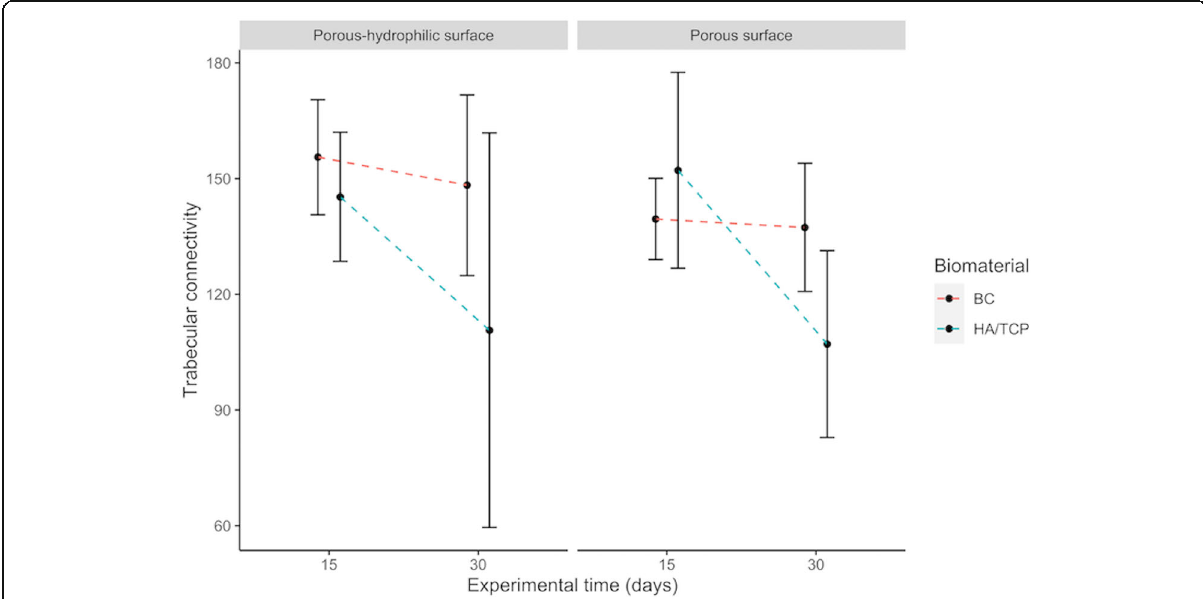
Fig. 5 Interactions among implant surfaces, bone substitute material or blood clot and experimental period on connectivity density. Error bars represent the standard deviation around the